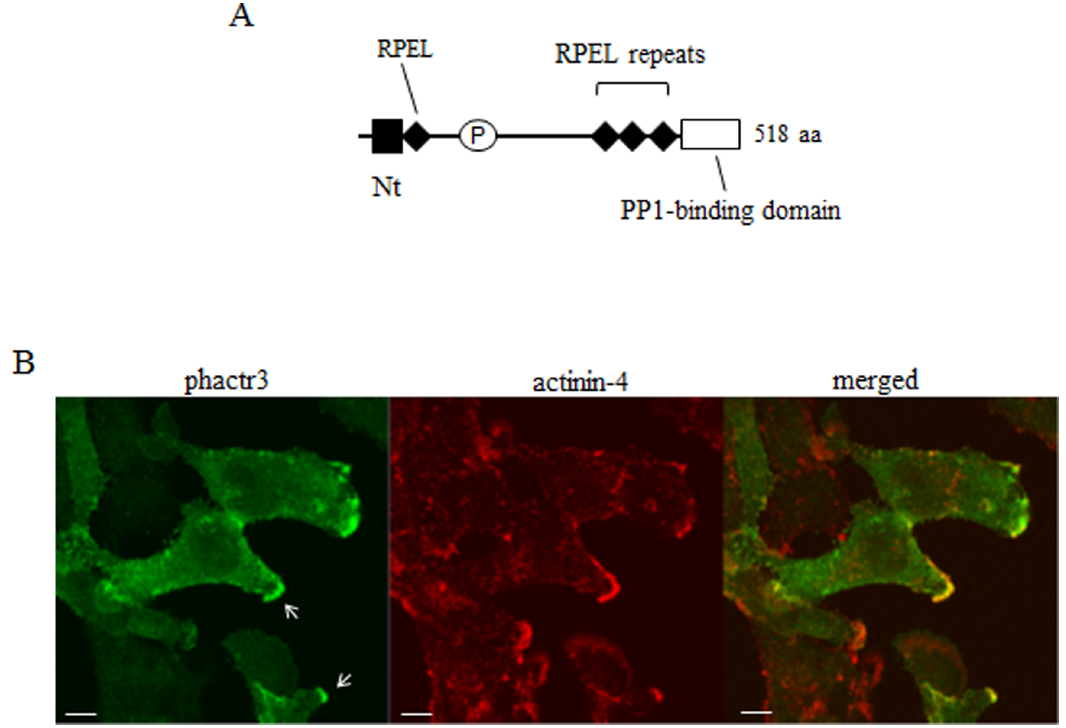
Figure 1. The distribution patterns of phactr3 in cells. (A) Primary structure of phactr3 (NP_001186435, 518 aa). RPEL, G-actin binding motif, and PP1-binding domain (PP1) are indicated. P, a region with a proline-rich sequence. The N-terminal region (Nt), RPEL motifs, and PP1-binding domain are highly conserved in the phactr protein family. (B) Localization of phactr3 in HeLa cells. We have previously established a HeLa cell line where phactr3 expression was induced by tetracycline [5]. The HeLa cells were cultured with tetracycline (0.5 m g/ml) for 24 h and immunostained with anti-phactr3 monoclonal antibody. The distribution patterns of phactr3 were compared with that of a -actinin 4, which is known to localize to the lamellipodia and membrane ruffles [20]. Bars, 20 m m.